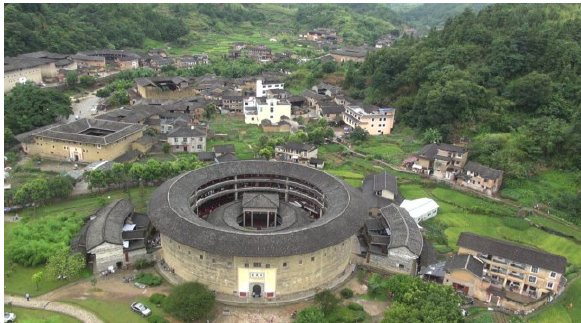
Figure 1 Example video frame of the study area in Longyan,